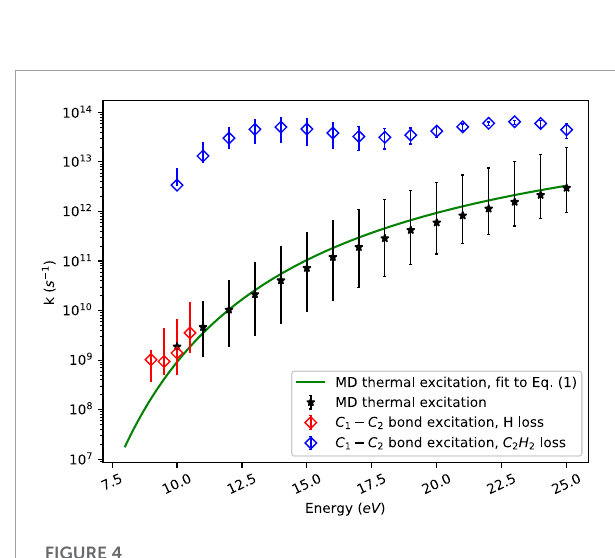
FIGURE 4 ReaxFF MD microcanonical rate constants for thermally excited indene and for excitation of a single carbon-carbon bond in the molecule. rearrangement of chains of carbon atoms. At the lower energies studied, the dissociation is dominated by the loss of one of the two hydrogen atoms in the CH group. At higher energies, product 2 molecules/radicals like C H or C H are also observed. 2 2 2 3